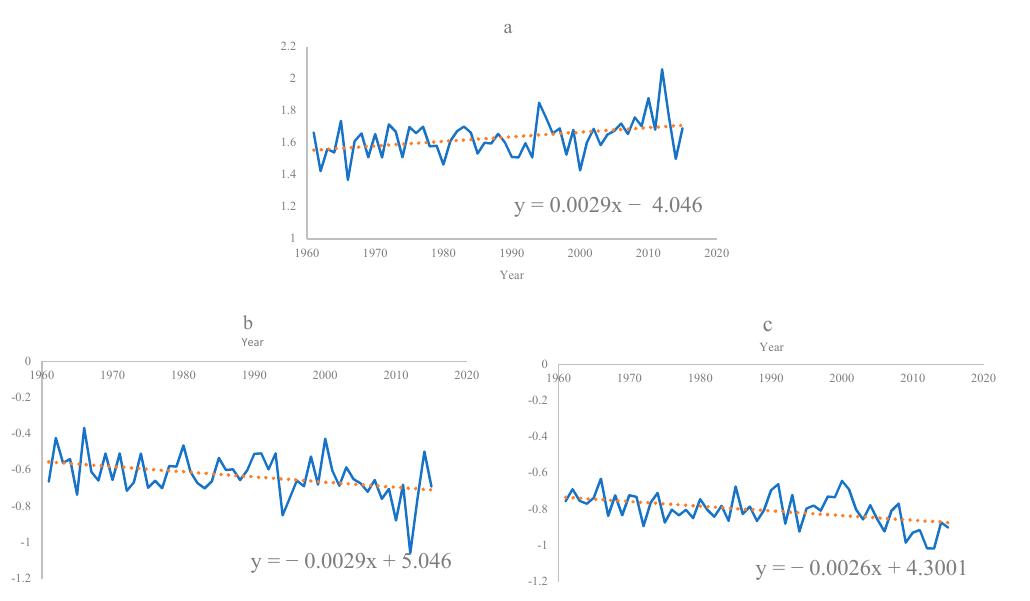
( b ), and ε n ( c ) in LRB from 1961 0